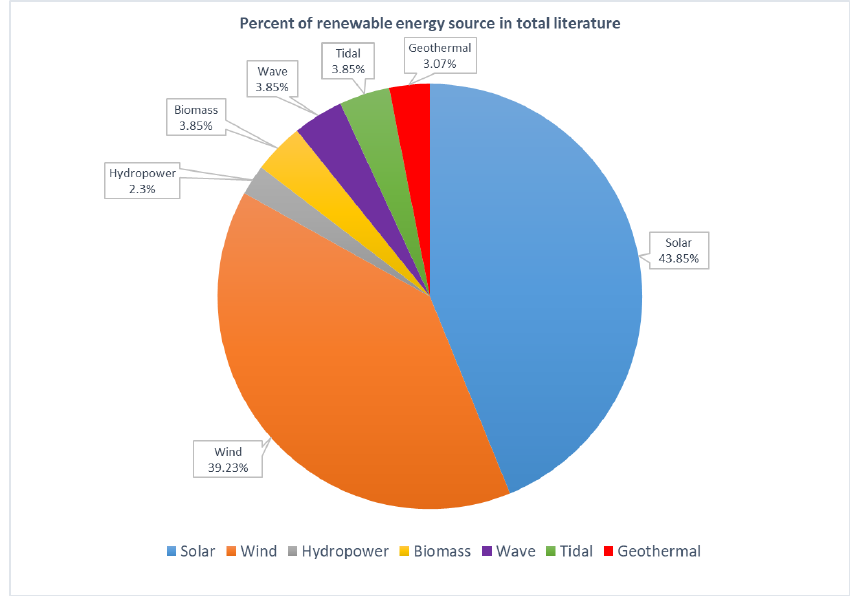
Figure 1. The pie chart in terms of seven renewable energy sources.